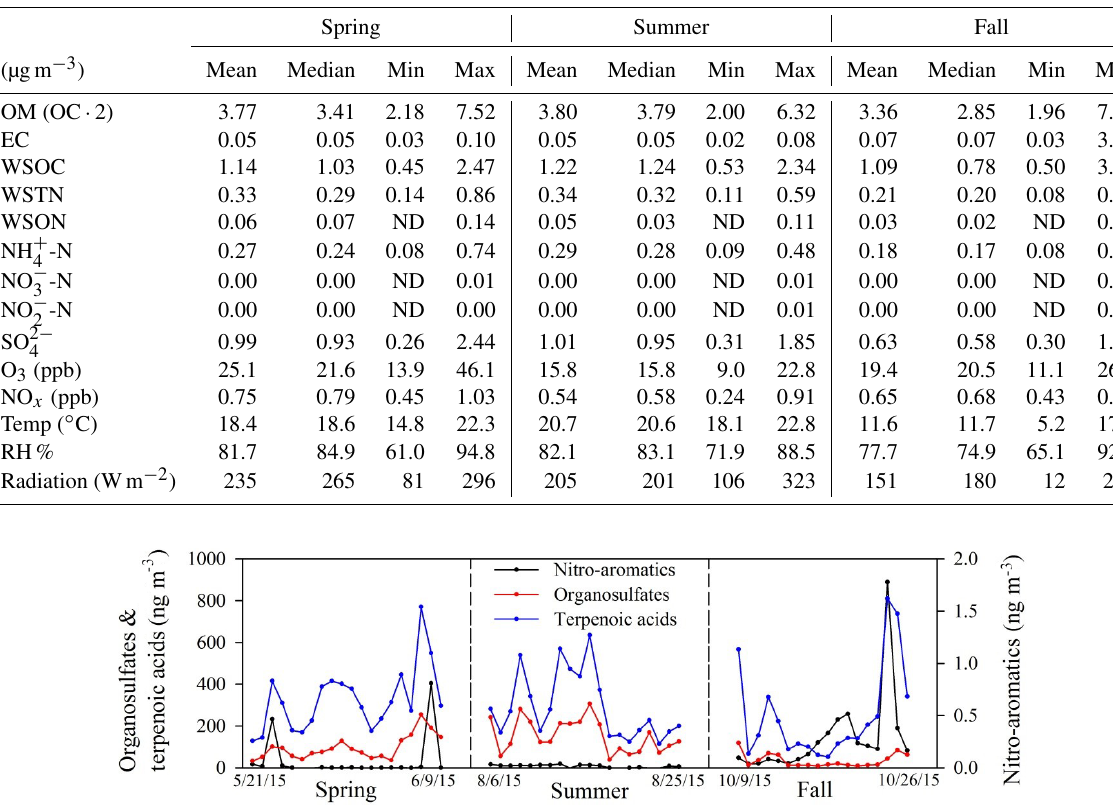
Table 1. Summary of particulate and gaseous species measured at the Coweeta sampling site in 2015. Spring Summer Fall